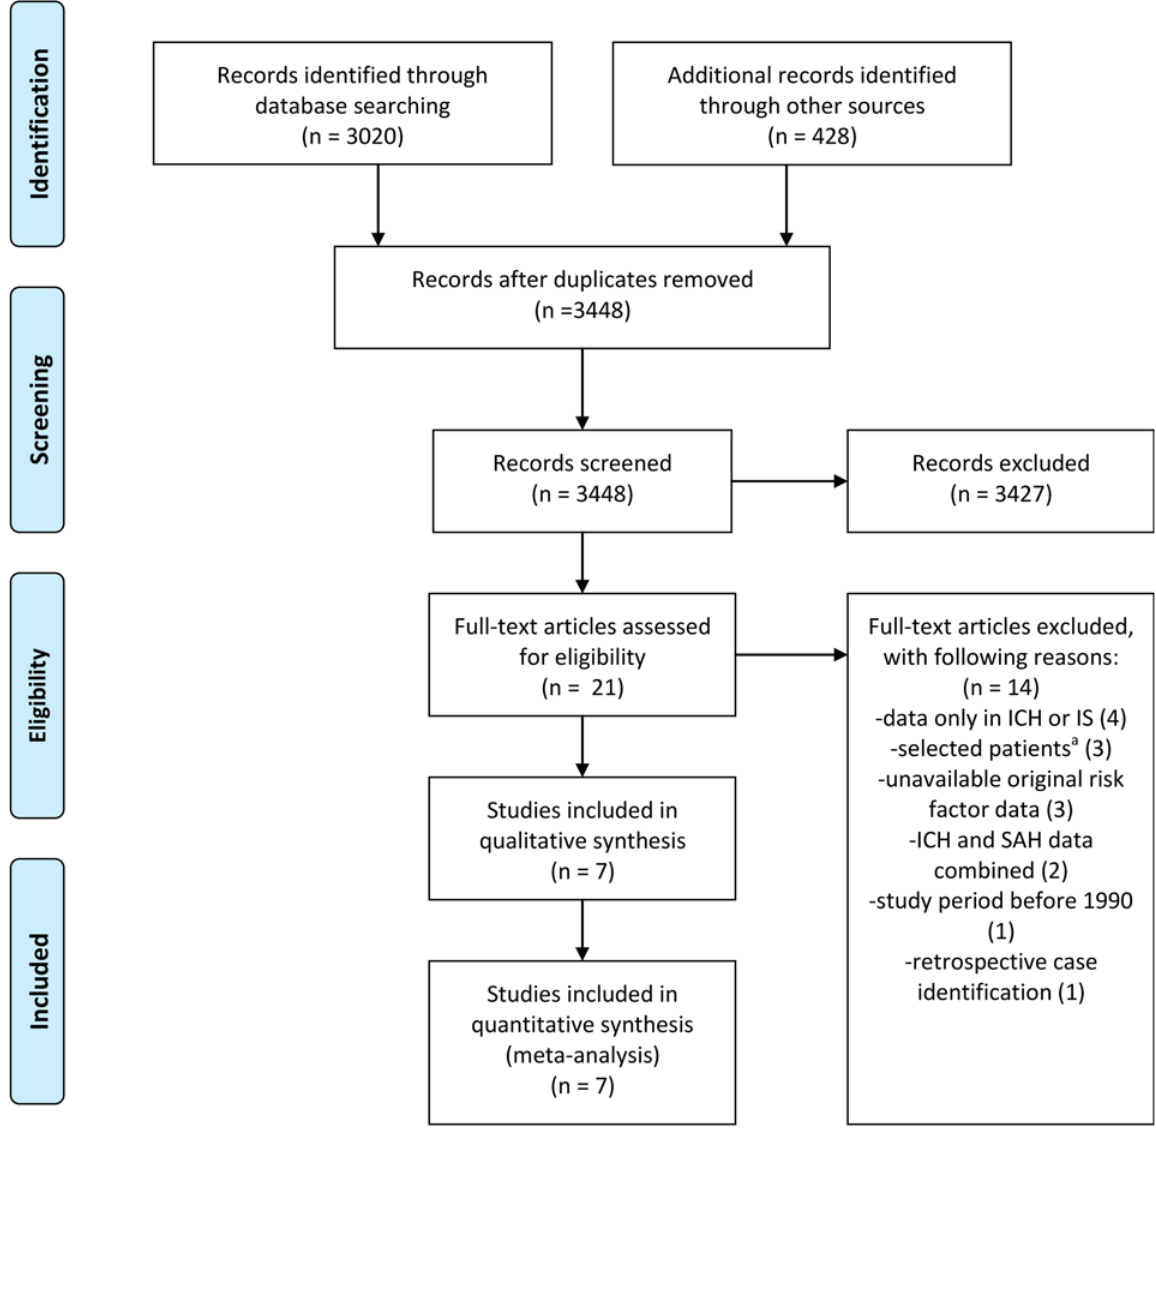
Fig 2. Selection of studies in white popuations. a. excluding patients with cardiogenic emboli, or both lacunar and cortical infarcts; data only in men; data only in patients with atrial fibrillation.